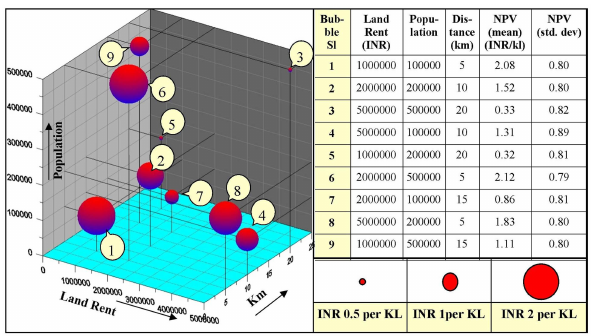
Figure 7. Net present values of typical cases.